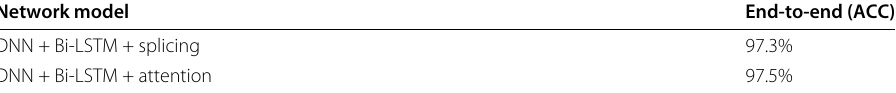
Table 8 Comparative experiment based on the effectiveness of the attention mechanism Network